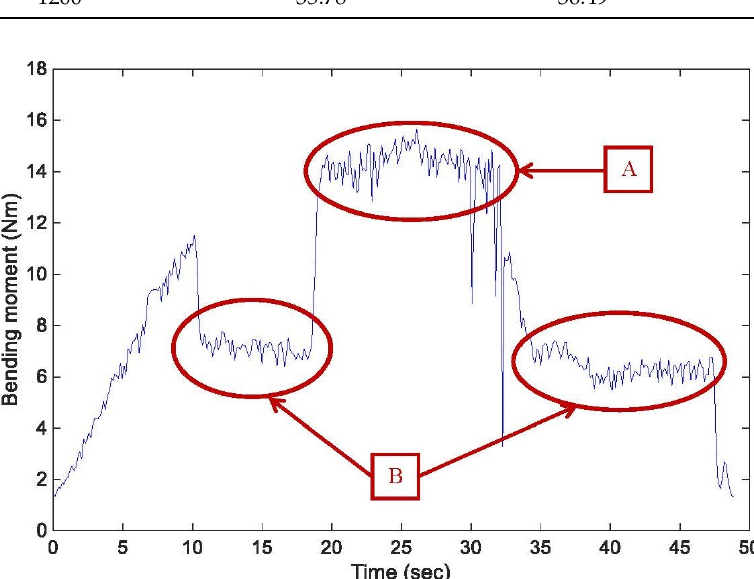
Figure 10. Variation in bending moments with a constant feed rate of 800